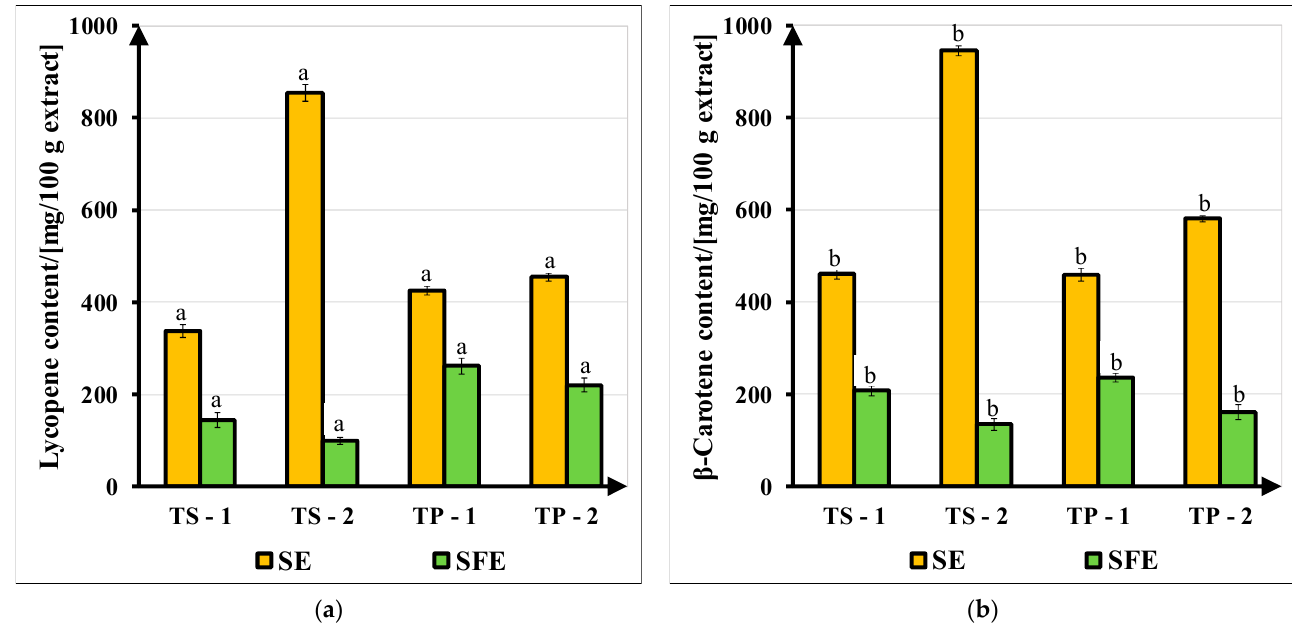
Figure 5. Carotenoid content of SE and SFE raw extracts obtained from tomato slices (TS) and tomato pomace (TP), using as extraction solvents (1) bioethanol and (2) ethyl acetate and as operating parameters set (1) at 400 bar, 70 °C, 9 kg/h and set (2) at 450 bar, 70 °C, 11 kg/h: ( a ) lycopene; ( b ) β - carotene. Different superscripts (a–b) indicate statistically different carotenoid concentration ( p < 0.05) at a level of significance α = 0.05.